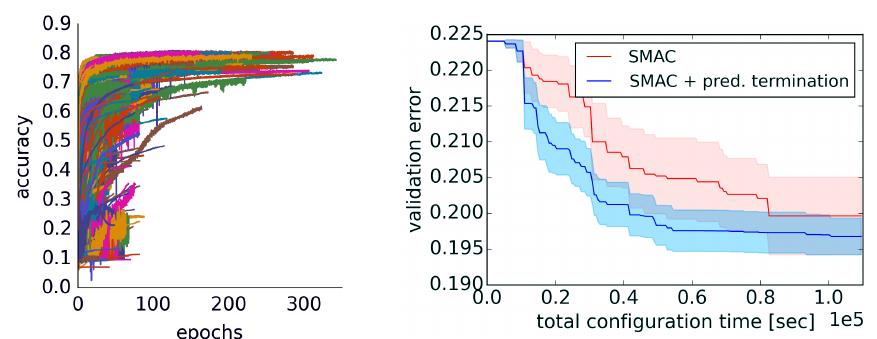
Figure 6. Evaluation of early termination on CIFAR-10. The ( left ) graph shows the learning curves of all hyperparameter configurations evaluated. The ( right ) graph shows the average validation error over time.